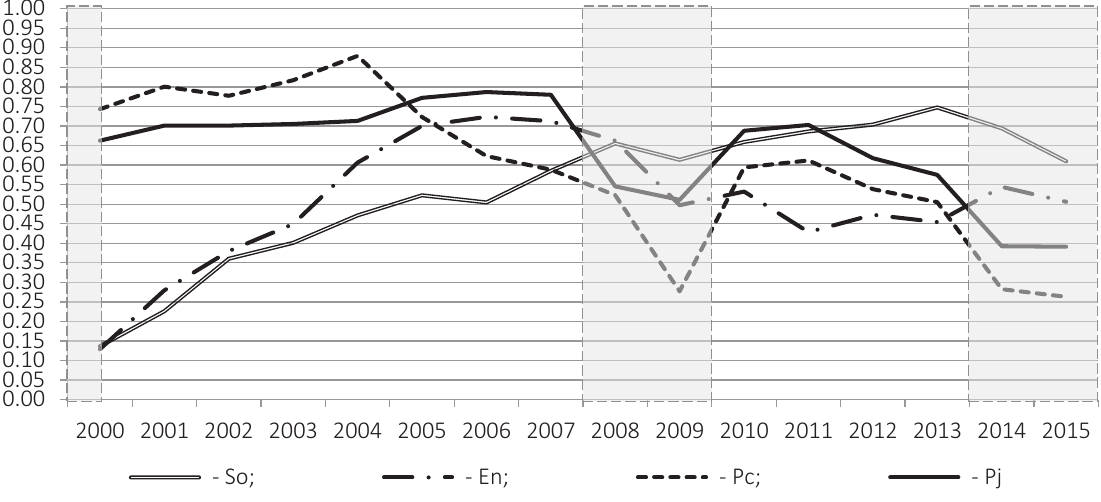
Figure 2. Graphical representation of the index estimations of the subsystems of socio-economic system of Ukraine for the period of 2000–2015 years*